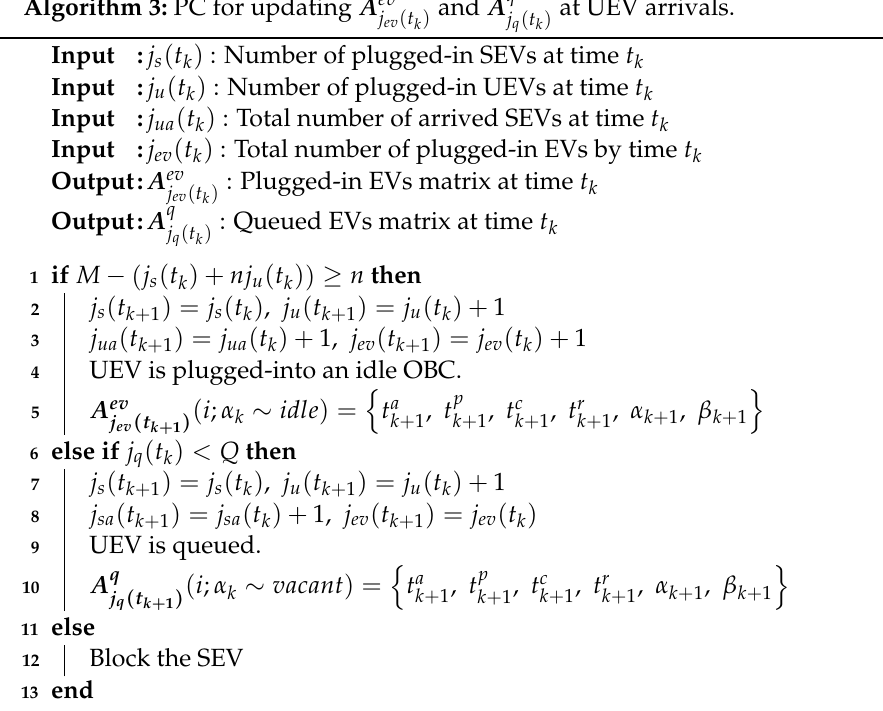
Algorithm 3: PC for updating A ev